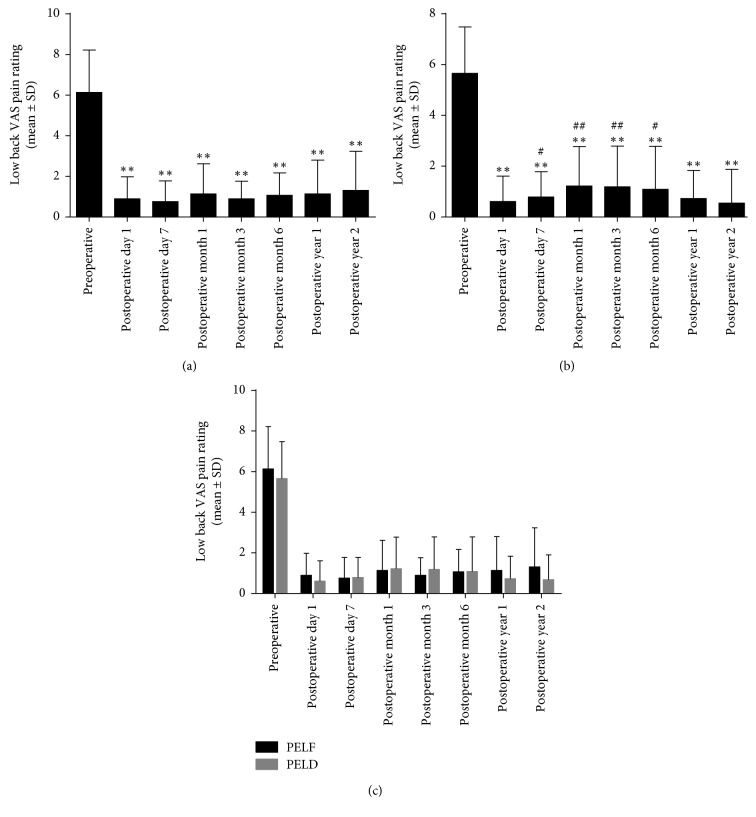
The low back pain VAS pain rating before and after TF PELF and PELD. (a) Low back pain was significantly decreased at all time points postoperatively compared with that preoperatively in the PELF group (P < 0.01), and no statistical difference was found between postoperative time points compared with postoperative 1-day (P > 0.05). (b) Low back pain decreased after TF PELD (P < 0.01), but increased at postoperative day 7, month 1, month 3, and month 6 compared with postoperative day 1 in the PELD group (P < 0.05). (c) No significant difference between the 2 groups over time (P > 0.05). ∗∗P < 0.01, compared with that preoperatively, ##P < 0.01, compared with postoperative 1-day.